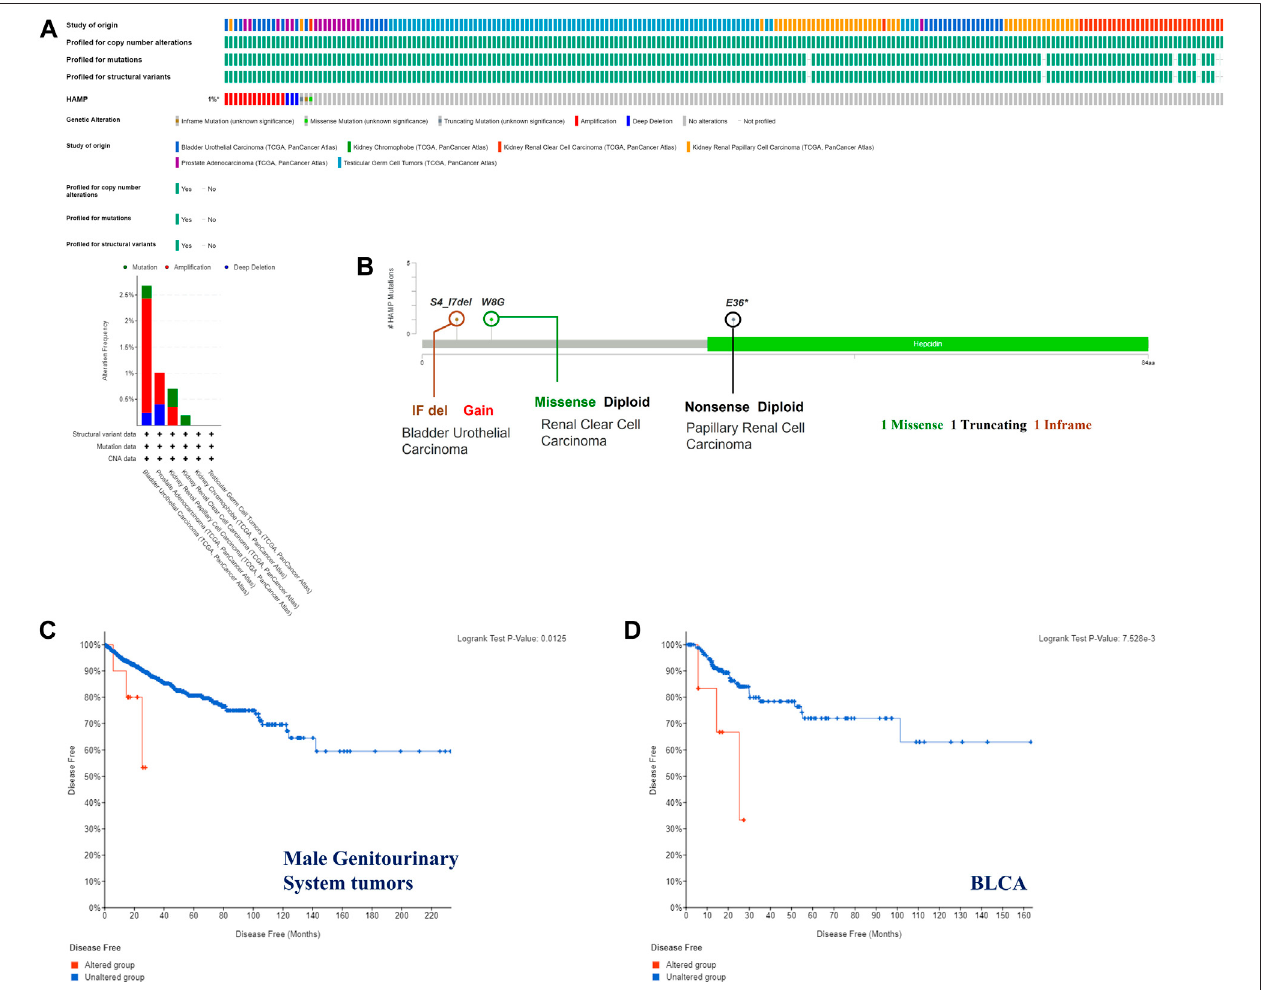
FIGURE 3 | Hepcidin alterations related to male genitourinary system tumors whose data are deposited in TCGA. Hepcidin alteration features analyzed by cBioPortal. (A) Alteration pattern, cancer types, and host altered sites (B) . There were three major alteration patterns: mutation colored green, ampli fi cation colored red, and deep deletion colored blue. Survival analysis (disease-free survival) was performed between the hepcidin alteration group and an unaltered group of (C) all male genitourinary system tumors and (D) bladder urothelial carcinoma (BLCA) to reveal the clinical signi fi cance of hepcidin alteration.